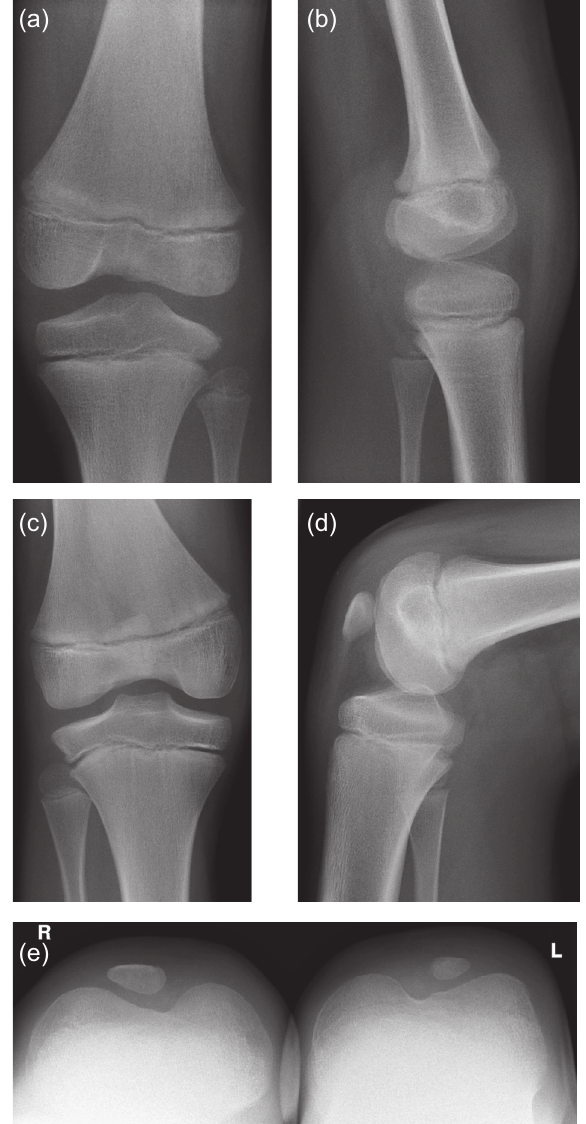
Figure 4. (a, b) Radiological follow-up two years postoperatively at age of eight no patella is seen on X-rays. (c–e) Six years postoperatively at age of 12 patellae are hypoplastic but centered and trochleae are